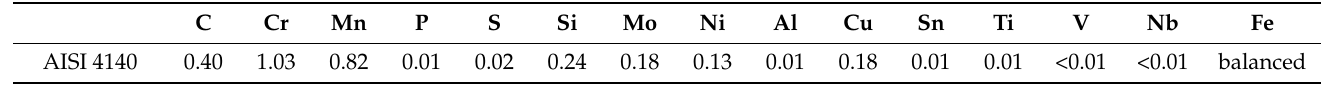
Table 1. The chemical composition of the workpiece material